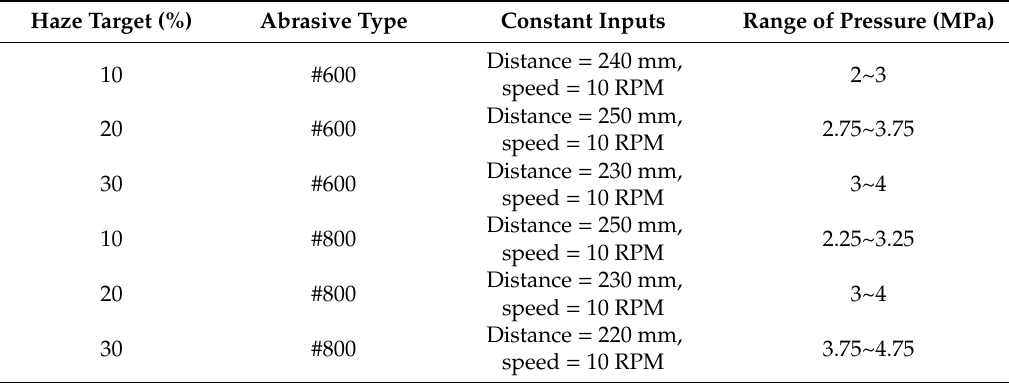
Table 2. The process ranges for testing of the developed process